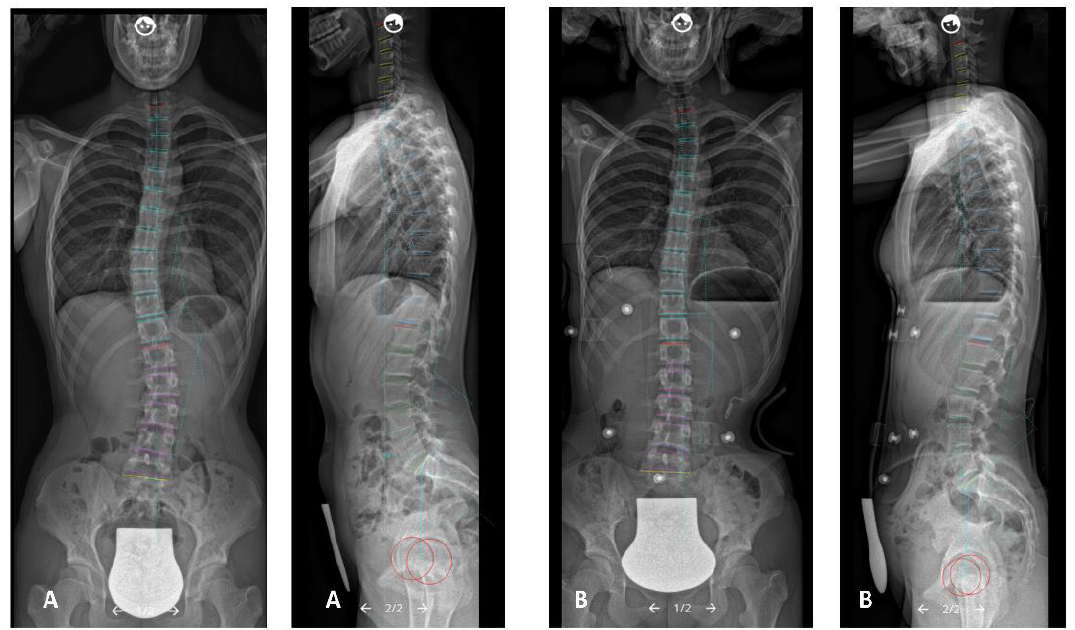
Figure 1. ( A ) Pre- and ( B ) in-brace anterio-posterior and lateral radiographs illustrating the analyzed spinal parameters (measurements with Surgimap software (Surgimap ® , New York, NY, USA)). Coronal parameters: primary Cobb angle for main curve, secondary Cobb angle for compensatory curve, coronal alignment (Calignment), C7-plumbline (C7PL). Sagittal spinopelvic parameters: T1–T12 thoracic kyphosis TK (T1–T12), T4–T12 tho- racic kyphosis TK (T4–T12), L1-S1 lumbar lordosis (LL), pelvic incidence (PI), pelvic tilt (PT), sacral slope (SS), C7-S1 sagittal vertical axis (SVA), T1-spinopelvic inclination (T1